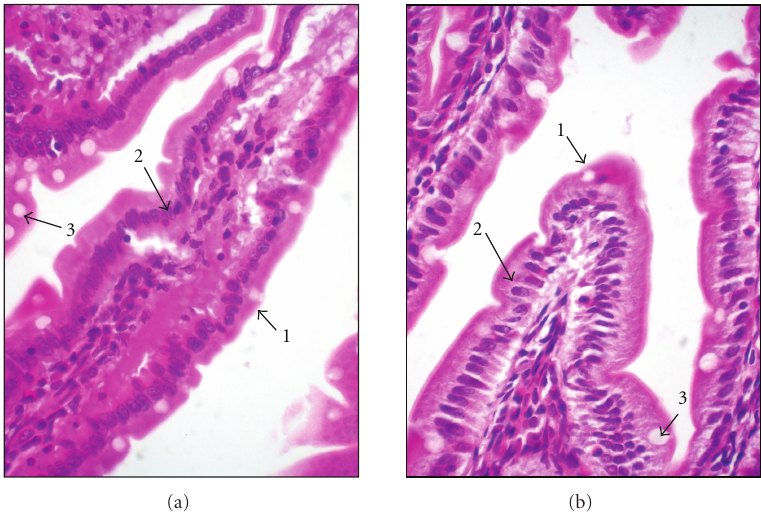
Figure 2: Histological duodenum sections of rats fed standard (based on egg white) diet (a) and CryIa12 toxin-containing diet (b) (600x amplification). Arrow 1 shows that the edge formed by microvilli remains intact for all treatments. Arrow 2 shows the nucleus of enterocytes, normal in all treatments. Arrow 3 shows the goblet cells with normal size for all treatments. The tissues were stained with